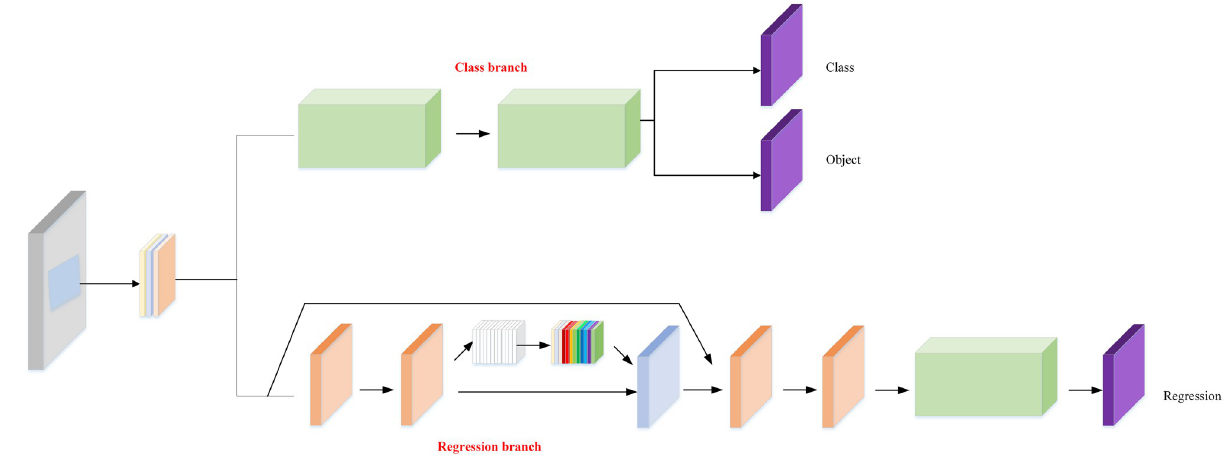
Fig 5. Decoupled head structure with attentional